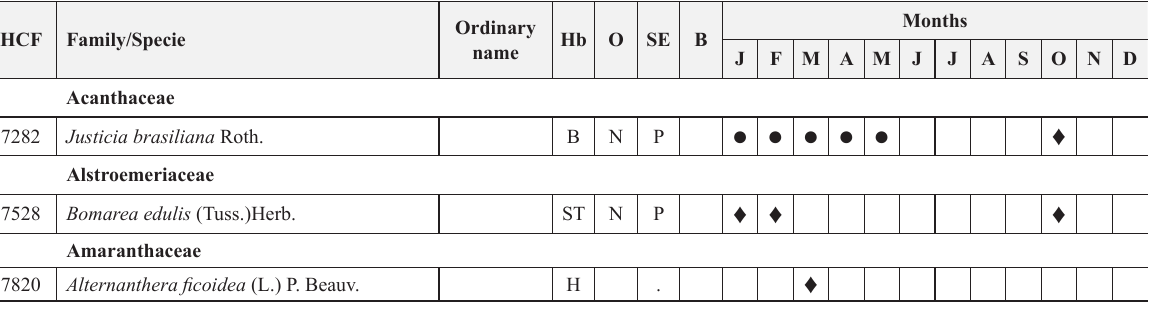
Blooming period of the collected species in the counties of Nova